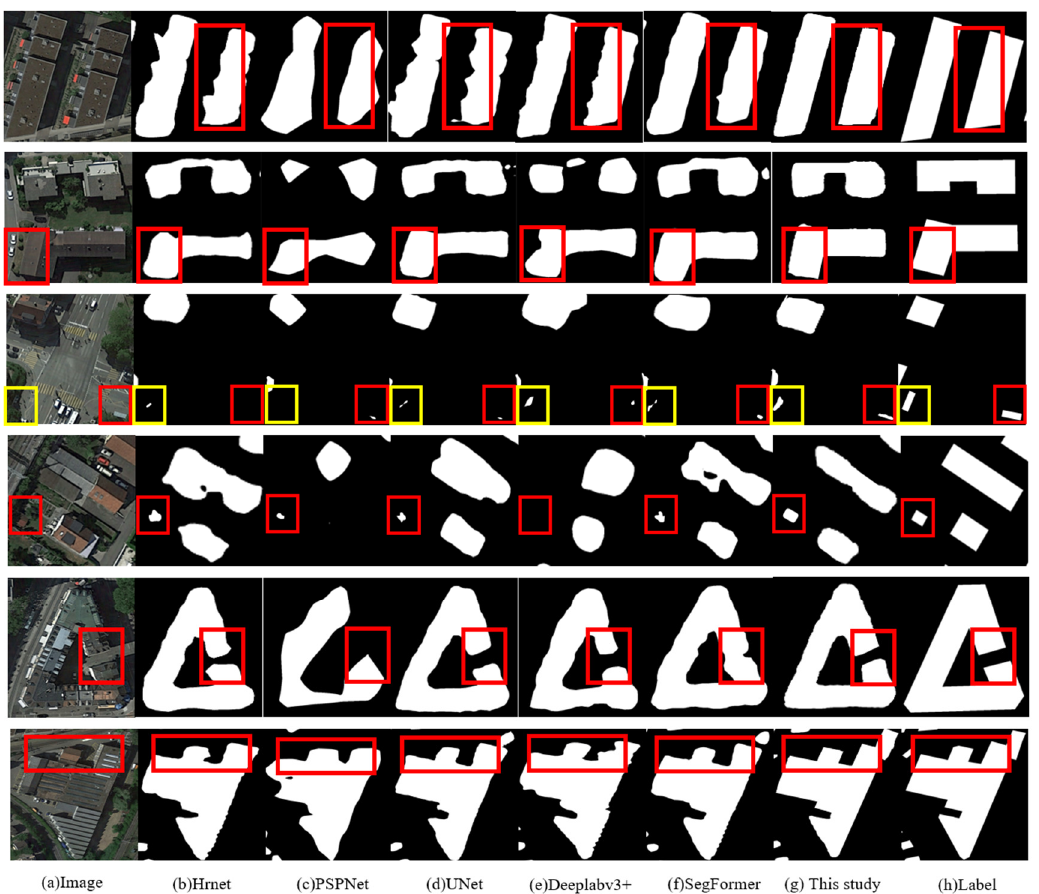
Figure 12. Detection effects of different networks: ( a ) original image; ( b ) Hrnet; ( c ) PSPNet; ( d ) UNet; ( e ) Deeplabv3+; ( f ) SegFormer; ( g ) this study; ( h ) label. ( e ) Deeplabv3+; ( f ) SegFormer; ( g ) this study; ( h )